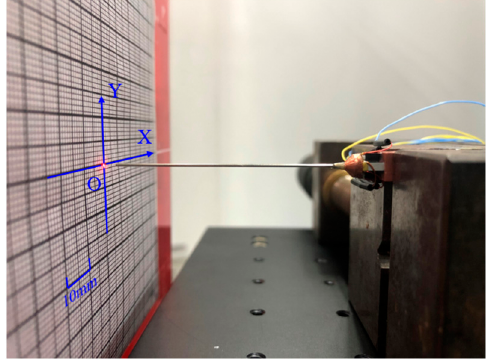
Figure 9. Principle prototype of optic scanner driven by CMPCs.